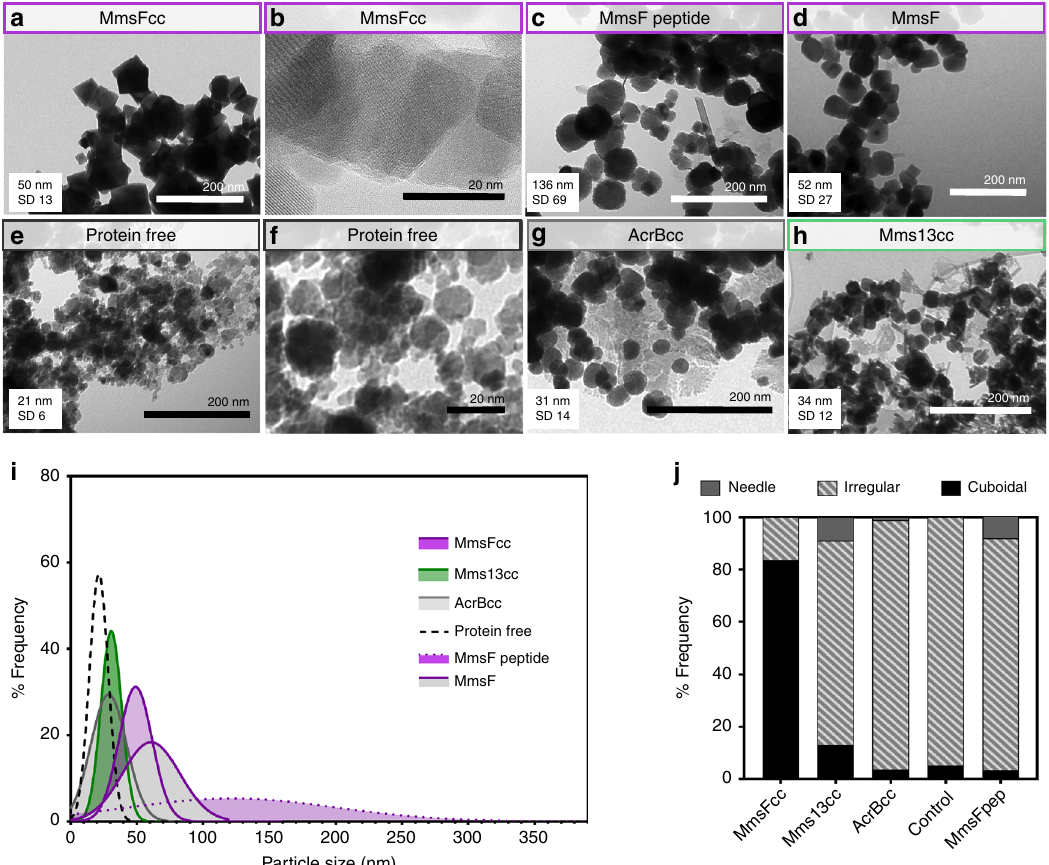
Fig. 3 MNP analysis. Transmission electron microscopy analysis of nanoparticles formed with a variety of different protein additives. Scale bars are indicated, and the mean particle diameters and standard deviations are shown. a MmsFcc, b MmsFcc at high magni fi cation (380,000×), c MmsF peptide, d MmsF (shown for comparison, see ref. 24 ), e protein free, f protein free at high magni fi cation, g AcrBcc. h Mms13cc. Data = mean with standard deviation ( n = 100) displayed in each image. i Histograms of particle sizes have been generated and fi tted to a Gaussian distribution for clarity (see S4 for raw histograms), j shape analysis of particles from TEM